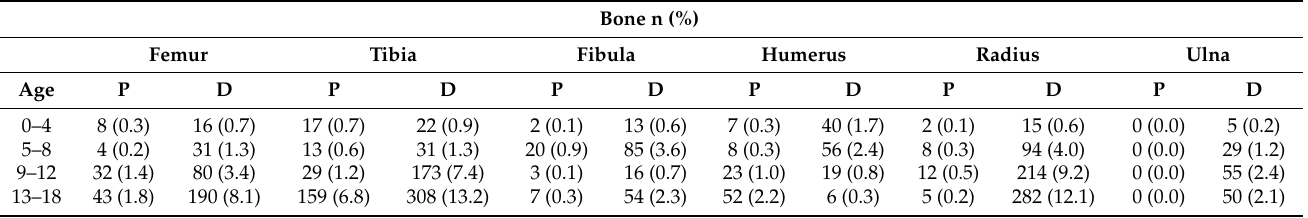
Figure 4. Number of physeal fractures at each age for females (blue) and males (red). Table 3. Physeal fractures for males according to age, long bone, and location (proximal or distal). N = 2338. Bone n (%)